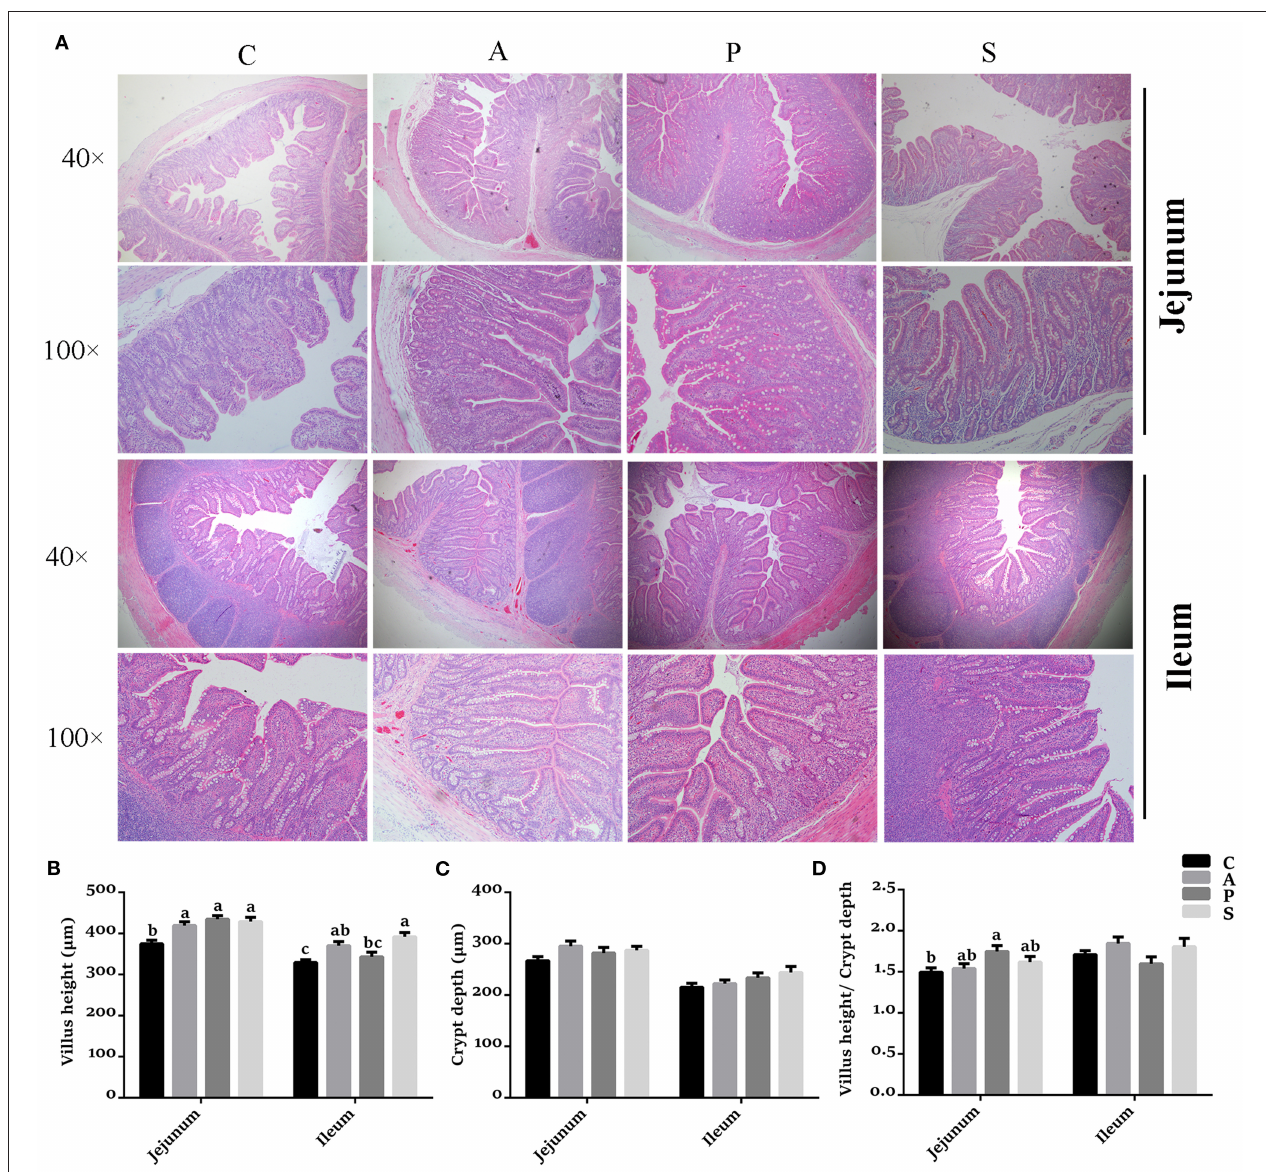
FIGURE 3 | Effects of maternal probiotic or synbiotic supplementation on the intestinal morphology of offspring piglets. Histomorphology of the jejunum and ileum was observed by light microscopy after H&E staining. (A) The images of the jejunum and ileum morphology at 40 × and 100 × magnification were shown, respectively. (B) Statistical analysis of villus height (VH), (C) crypt depth (CD), and (D) the ratio of VH to CD. Data are represented as means ± SEM, n = 8 per group. Different letters indicate significant differences among the groups ( P < 0.05). C, control group; A, antibiotic group; P, probiotic group; and S, synbiotic